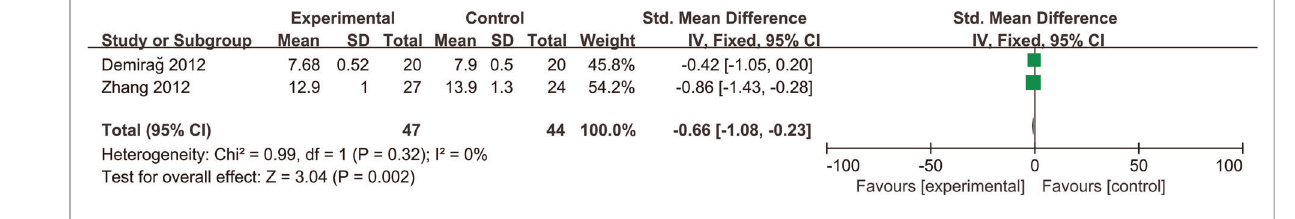
FIGURE 12 Forest pot for tibial tunnel enlargement.